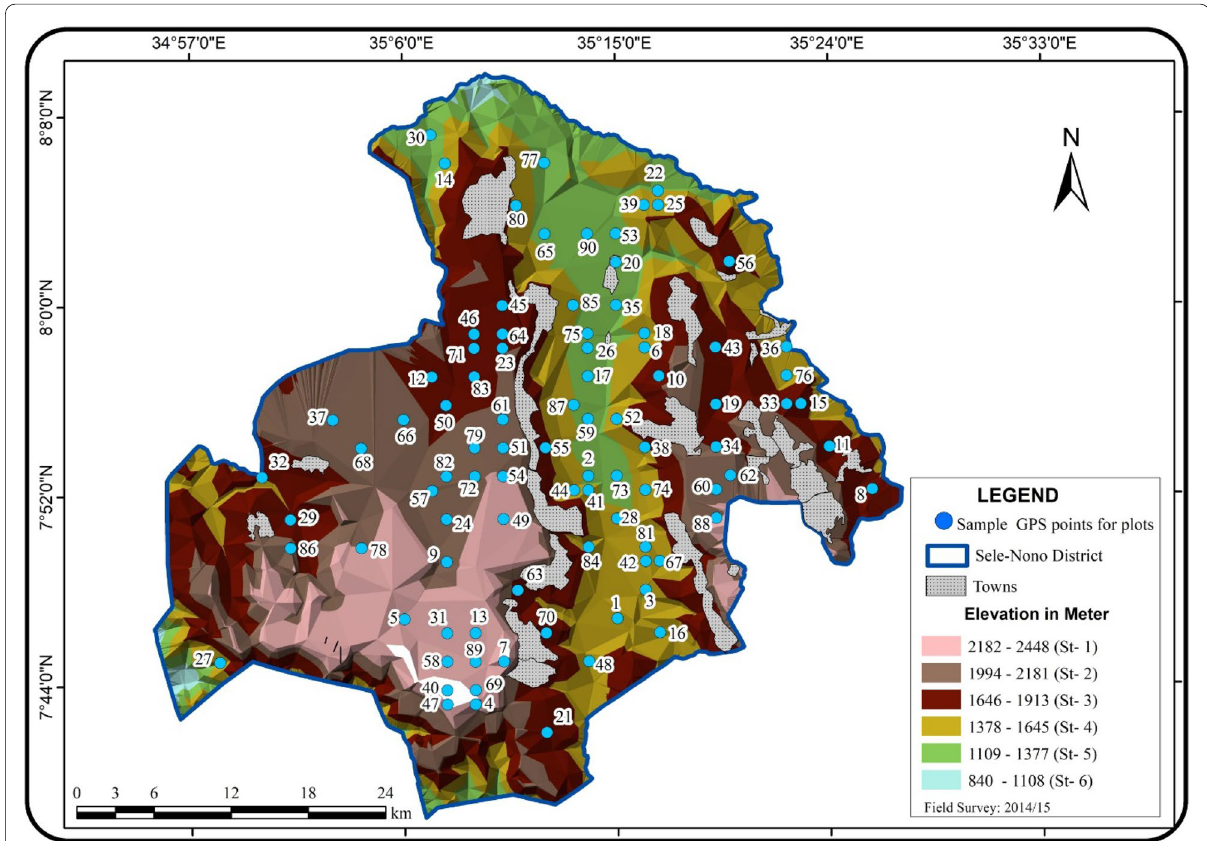
Fig. 2 Location of permanent sample plots in the study area. Numbers on the map are plot